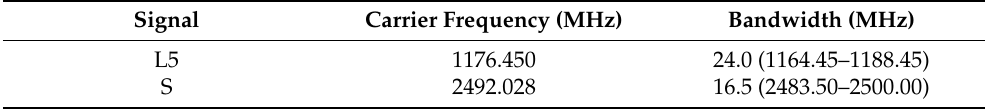
Table 2. Information about IRNSS